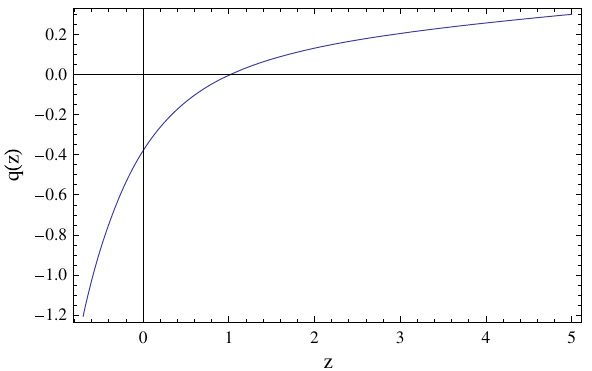
Fig. 30 Variation of V ( z ) with the variation of z (Model IV) by con- sidering the best fit values w 0 = − 0 . 766 ,w 1 = 0 . 307